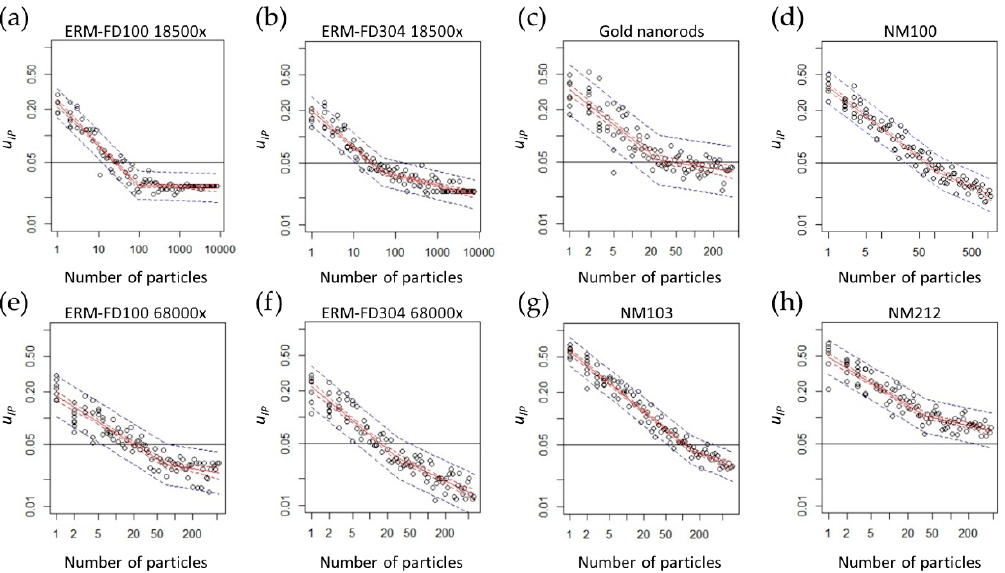
Figure 4. Log-log relationship between the number of measured particles and the u IP values obtained for ( a ) ERM-FD100 18,500 × , ( b ) ERM-FD304 18,500 × , ( c ) Gold nanorods, ( d ) NM-100, ( e ) ERM-FD100 68,000 × , ( f ) ERM-FD304 68,000 × , ( g ) NM-103, and ( h ) NM-212. The red lines show the piecewise log-log linear regressions. Red dashed lines and blue dashed lines show, respectively, the 95% confidence and the 95% prediction bands, around the regression lines.